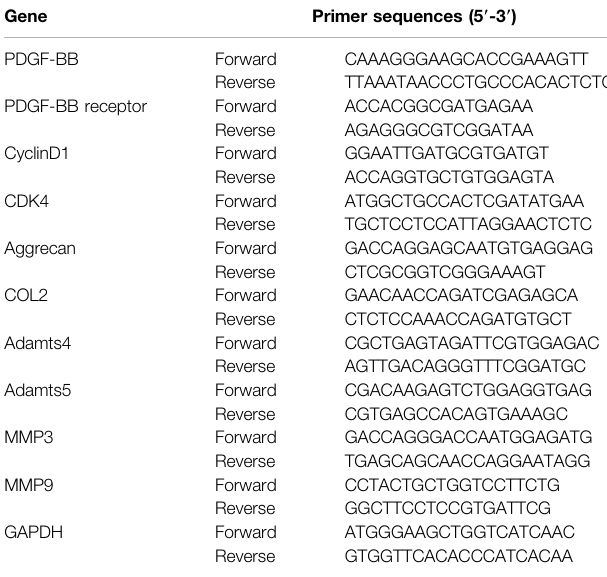
TABLE 2 | The primers sequences for Real-time